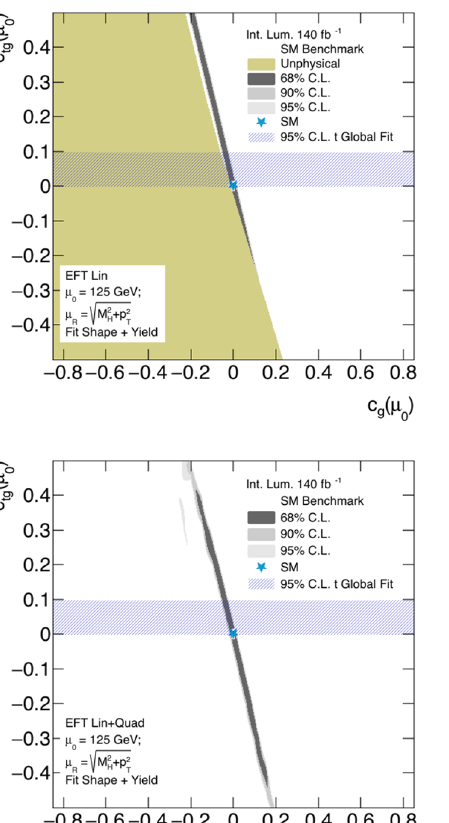
< T spectrum for a T